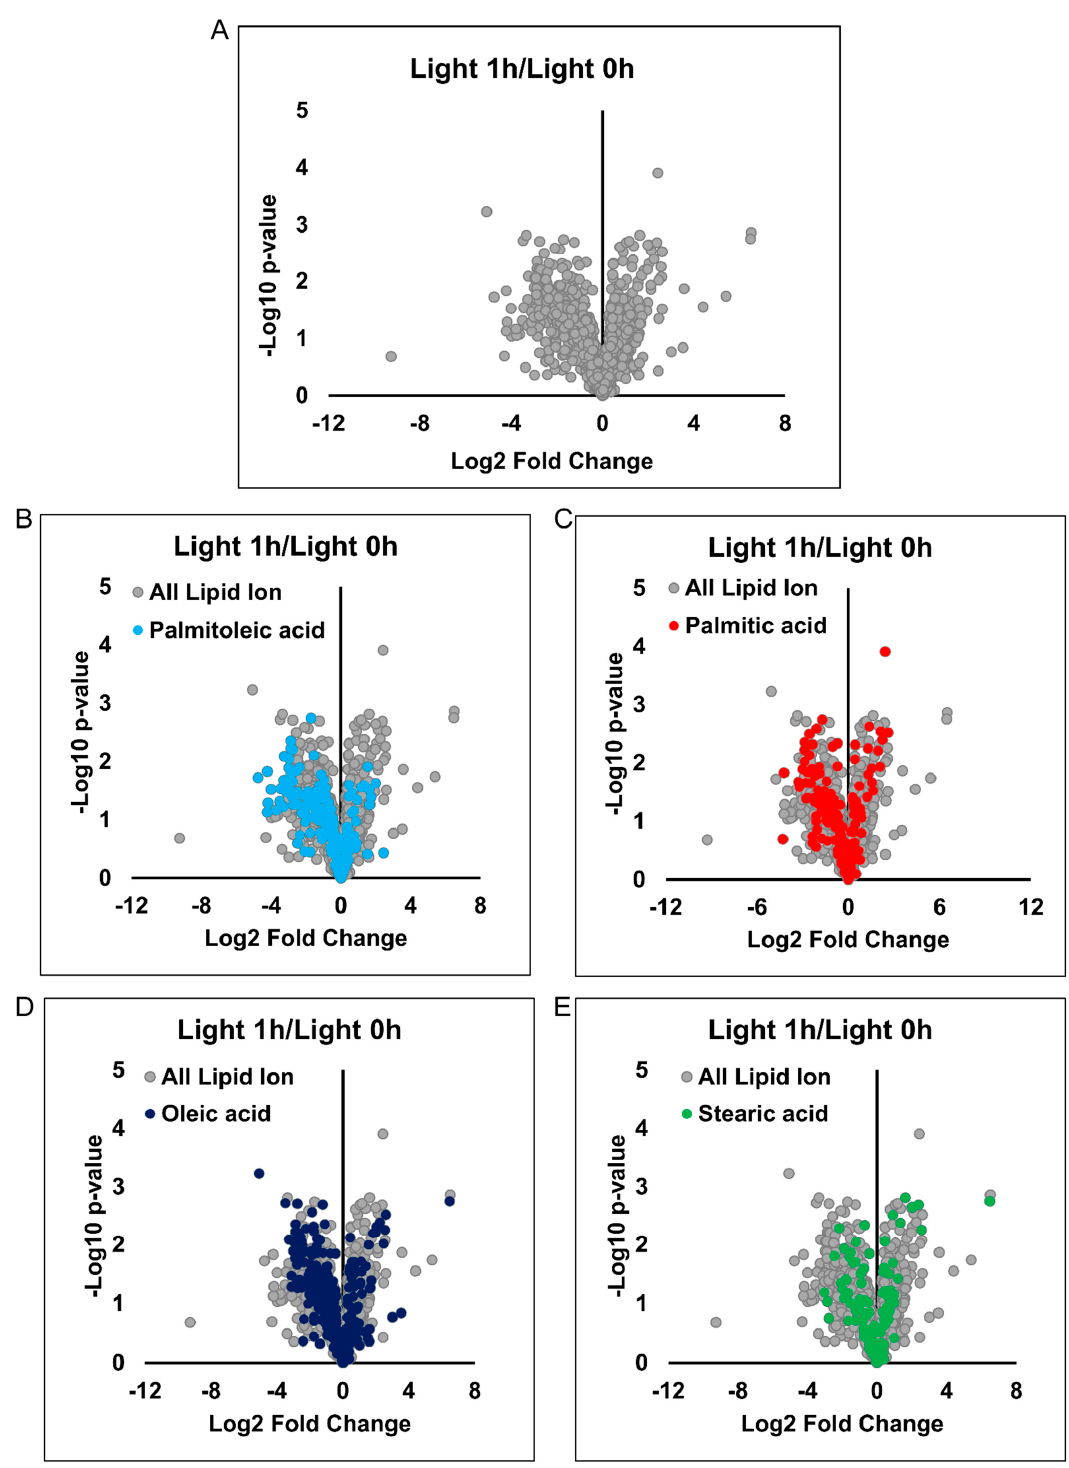
Figure 7. LC-MS/MS showing the cellular lipid composition barely changed due to optoKiC. ( A ) Vol- cano plot between Light 1-h (illuminated for 1 h) and Light 0-h (keep in dark for 1 h). ( B ) Volcano plot between Light 1-h and Light 0-h in which lipids containing 16:0 palmitic acid are labeled in red. ( C ) Volcano plot between Light 1-h and Light 0-h in which lipids containing 16:1 palmitoleic acid are labeled in light blue. ( D ) Volcano plot between Light 1-h and Light 0-h in which lipids containing 18:1 oleic acid are labeled in dark blue. ( E ), Volcano plot between Light 1-h and Light 0-h in which lipids containing 18:0 stearic acid are labeled in